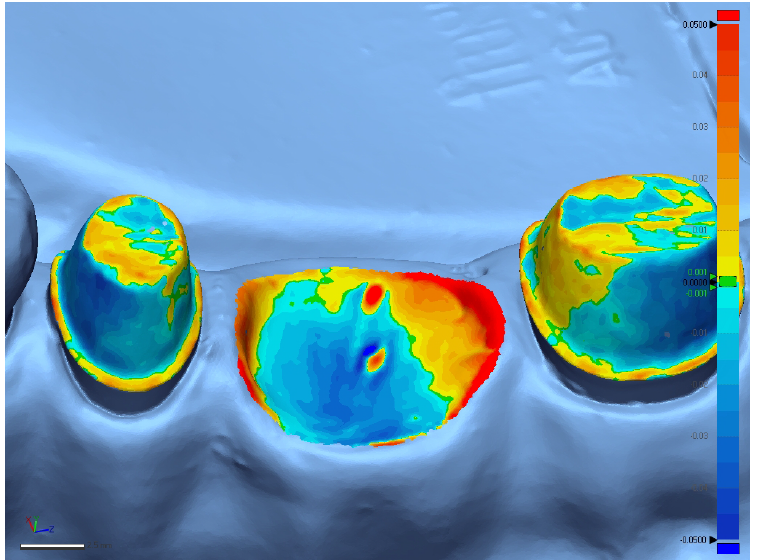
Figure 1. Color-coded map of the analyzed area. Deviation is displayed in mm on the color scale with outward (red) and inward (blue) displacement.